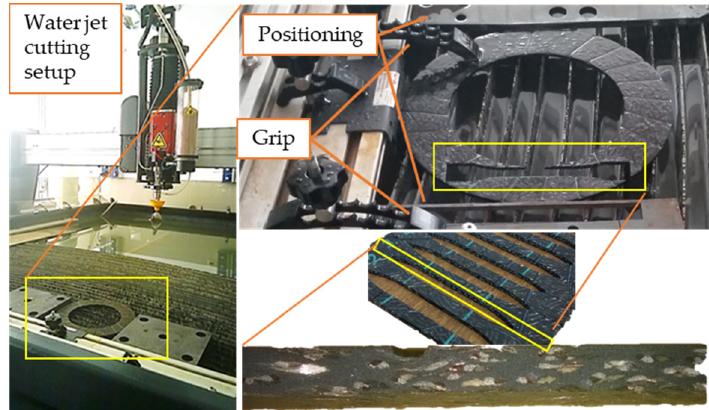
Figure 9. The 1515 MAXIEM OMAX abrasive water jet cutting machine and the smooth cutting edge of a test specimen.